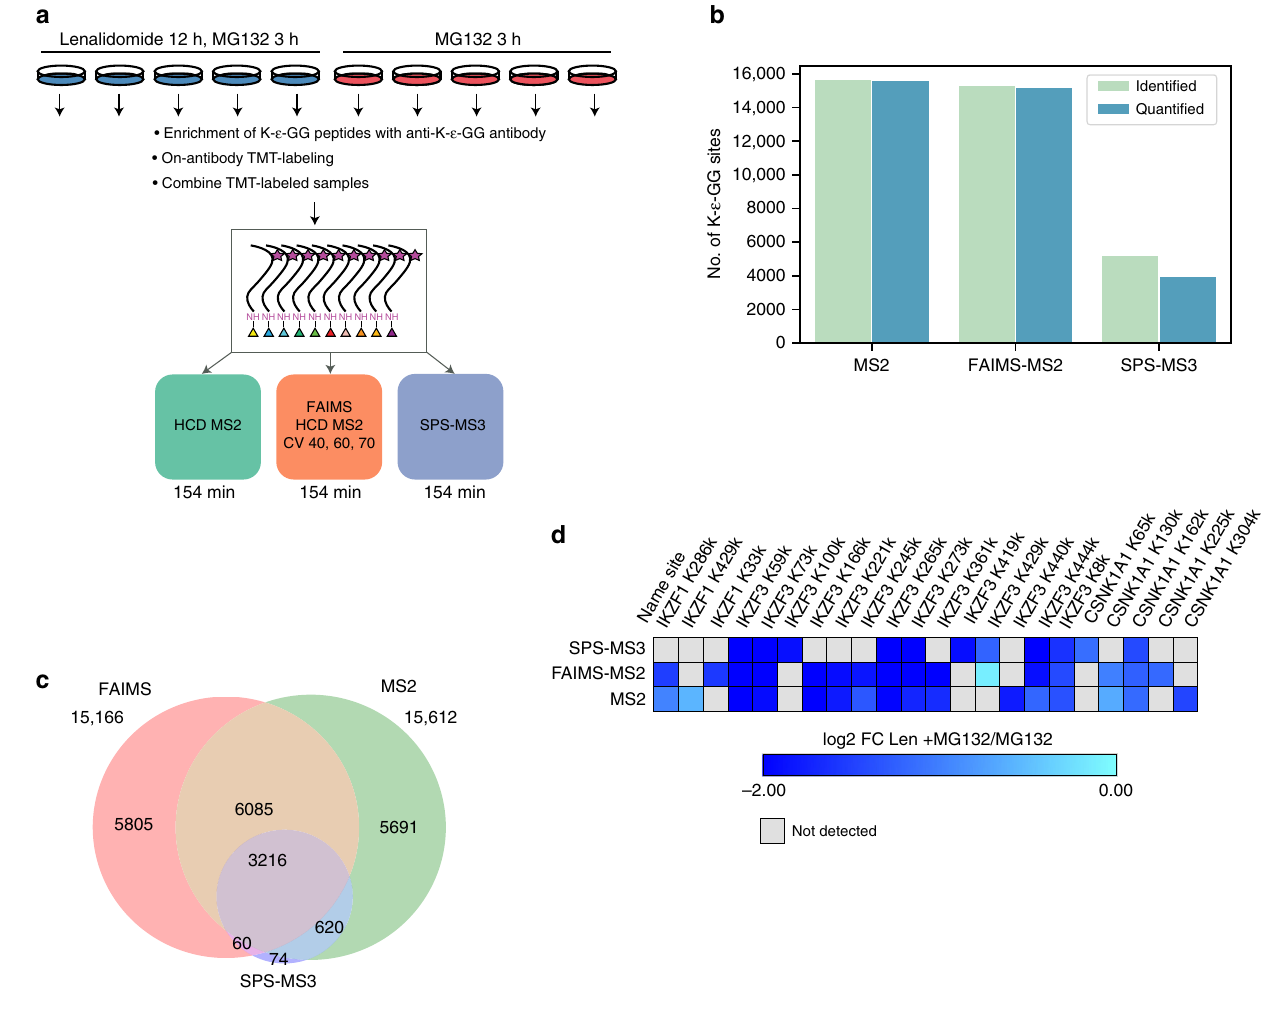
Fig. 2 Benchmarking UbiFast. a Experimental design for TMT10-based assessment of global changes in ubiquitylation and protein levels. On-antibody K- ɛ - GG enrichment and TMT labeling are benchmarked in lenalidomide-treated MM1S cells using HCD-MS2, SPS-MS3, and FAIMS-MS2. b Bar plots show the number of distinct quanti fi ed K- ɛ -GG sites identi fi ed in each type of MS experiment. c Venn diagram shows the overlap of quanti fi ed K- ɛ -GG sites across each MS experiment type (HCD-MS2, SPS-MS3, FAIMS-MS2). d Heatmap of log2 fold-change values for 12 h lenalidomide + 3 h MG-132 vs. 3 h MG-132 treated MM1S cells for IKZF1, IKZF3, and CSNK1A1. HCD-MS2 and FAIMS-MS2 data have been fi ltered to show only those sites that had >90%